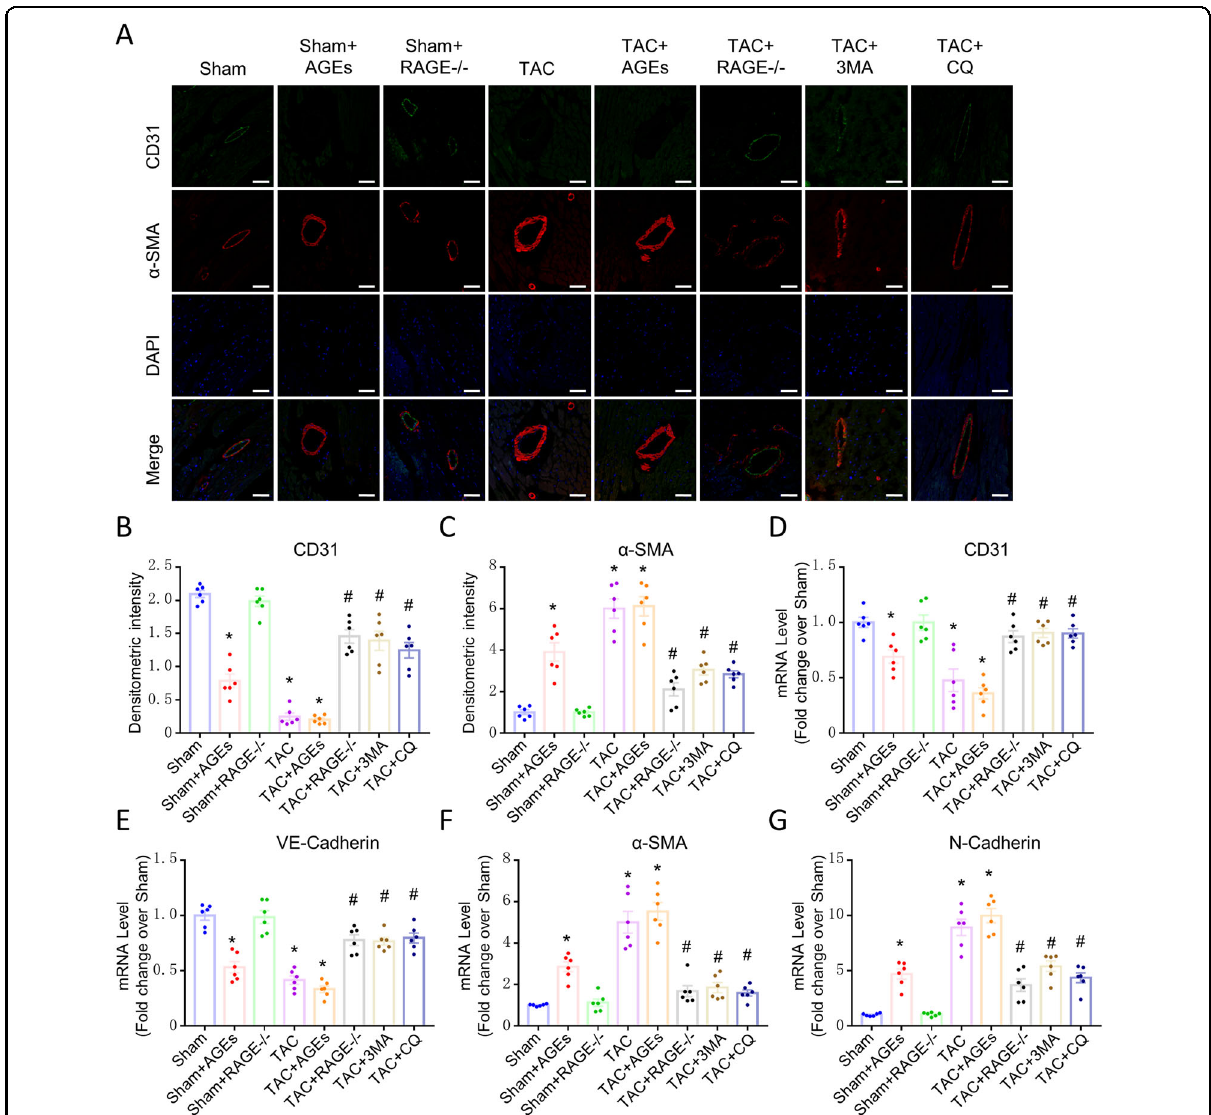
Fig. 3 Endothelial cells may transition to mesenchymal cells in HF. A Confocal microscopic image of double immuno fl uorescence staining with CD31 (green) and α -SMA (red); nuclei were counter stained with DAPI (blue); Scale bars = 100 µm. B , C Quanti fi cation of immuno fl uorescence analysis. mRNAs for endothelial cells-associated genes [CD31 ( D ), VE-Cadherin ( E )] and mesenchymal cells-associated gene [ α -SMA ( F ) and N- Cadherin ( G )] were measured by qPCR. n = 6. Data are presented as mean ± SEM. * p < 0.05 vs. sham group, # p < 0.05 vs. TAC